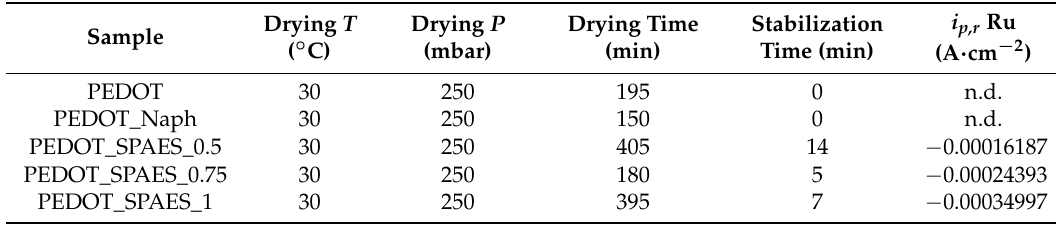
Figure A12. Cyclic voltammograms of PEDOT and PEDOT_Naph dissolved in DMF or NMP (Tables A1 and A4). The electrochemical probe is 3 mM [Ru(NH 3 ) 6 ]Cl 3 . Table A2. Drying temperature, pressure, and time of PEDOTs’, PEDOT_Naphs’, and PEDOT_SPAESs’ polymeric solutions in DMAc, and the stabilization time and current of the